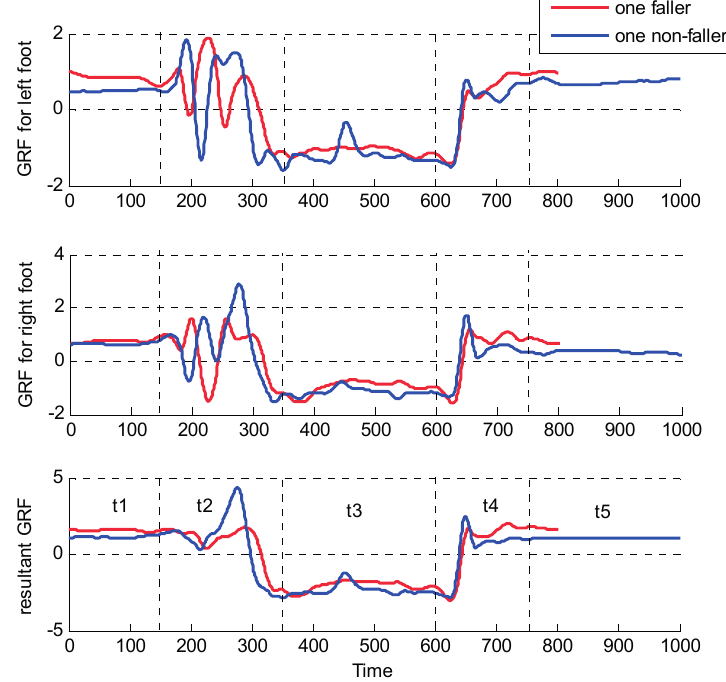
Figure 2. GRF on the force plate during STS movement. At the beginning of STS movement, the person keep on stand (t1). The time from stand to sit on t2, from sit to stand on t4. The curves for faller are smoother than the non-faller, with lower